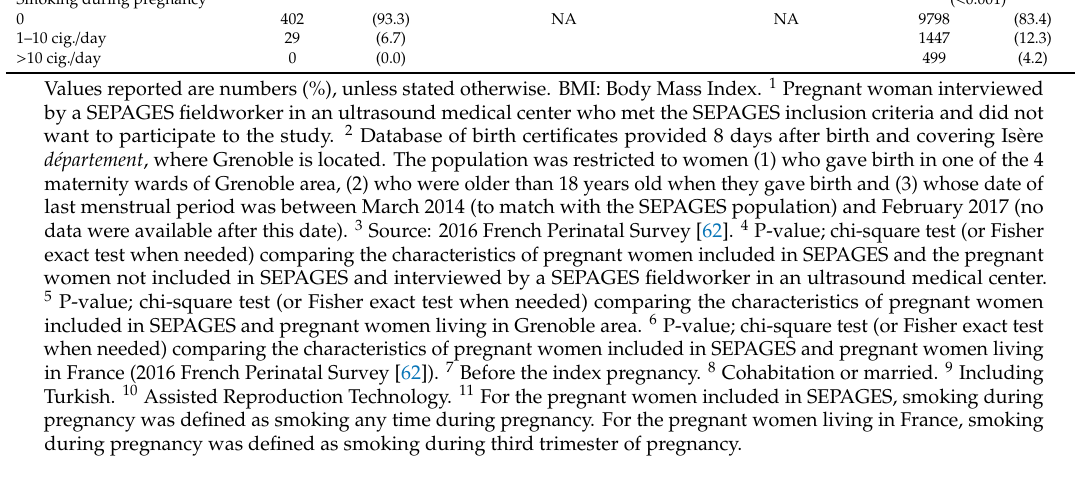
Table 2. Description of the children from SEPAGES cohort, and comparison with newborns from Grenoble and